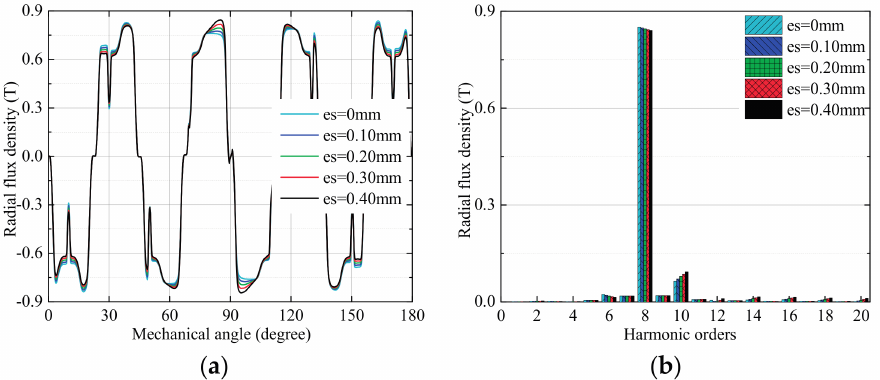
Figure 4. Analysis of the radial component of magnetic flux density in the IPMSM with stator deformation at no-load condition. ( a ) Distribution curves; ( b ) Harmonic